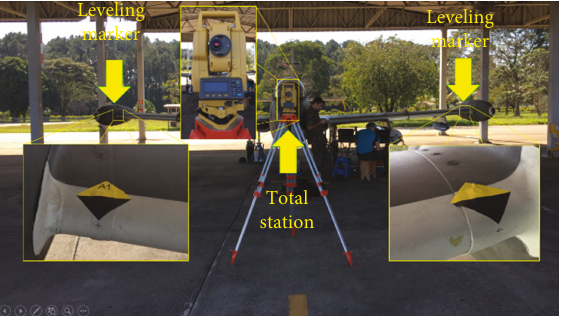
Figure 7: Topographic polygon ( P coordinates of the reference marks.